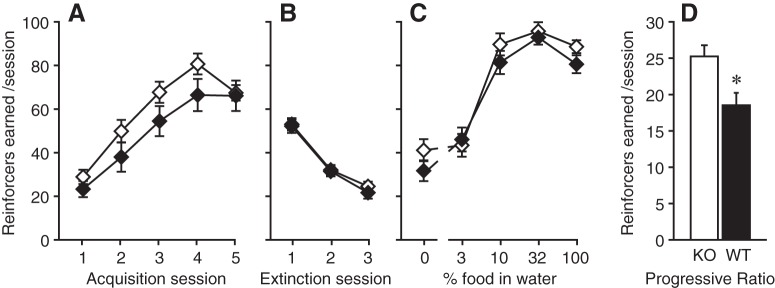
Food-reinforced operant behaviors. Reinforcers earned per session under an FR 1 schedule of reinforcement, as a function of (A) successive acquisition sessions, (B) successive extinction sessions, (C) reinforcer magnitude (dilutions of liquid food in water), and (D) with undiluted food under a PR schedule of reinforcement. KO mice (open symbols) earned significantly more reinforcers under the PR schedule but were comparable to WT mice (black symbols) in all other phases of testing; *p < 0.05 versus KO; n = 18–21.Figure Contributions: Annika Billefeld Bornebusch and Saiy Kiasari collected the data. Morgane Thomsen designed the experiments. Annika Billefeld Bornebusch and Morgane Thomsen analyzed the data.